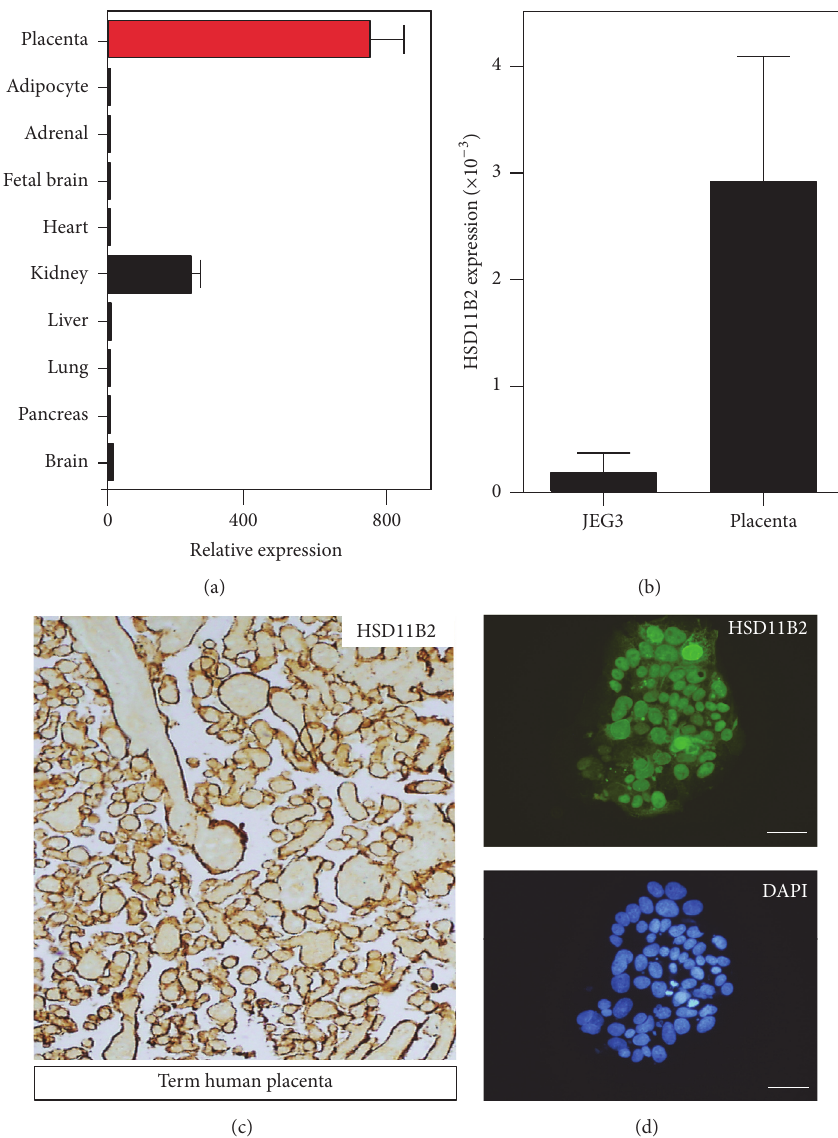
Figure 1: (a) Expression of data derived from the BioGPS database showing relative HSD11B2 expression across multiple human tissues. (b) Real-time PCR showing HSD11B2 expression in the term human placenta and in JEG-3 cells using the 2-delta-Ct method ( 𝑁 = 3 , 𝑝 > 0.05 , unpaired Student’s 𝑡 -test; housekeeping gene 18S). Representative photomicrographs of (c) a term human placenta and (d) JEG-3 cells immunocytochemically stained for 11 𝛽 -HSD2. Scale bar = 50 𝜇